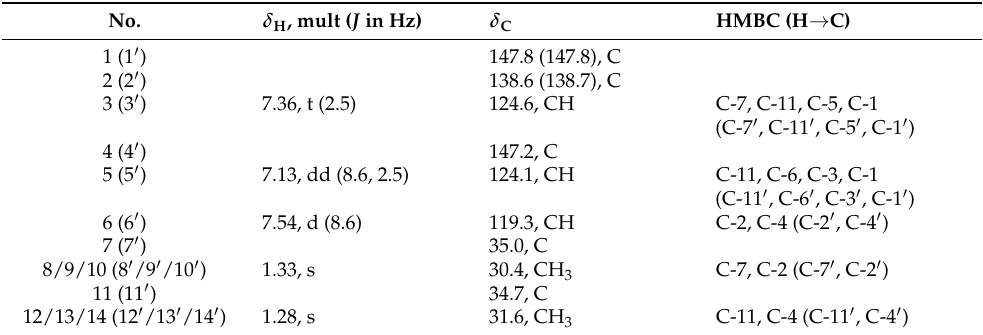
Table 2. 1 H-NMR (600 MHz), 13 C NMR (150 MHz) data, and HMBC correlations of compound 2 in CDCl 3